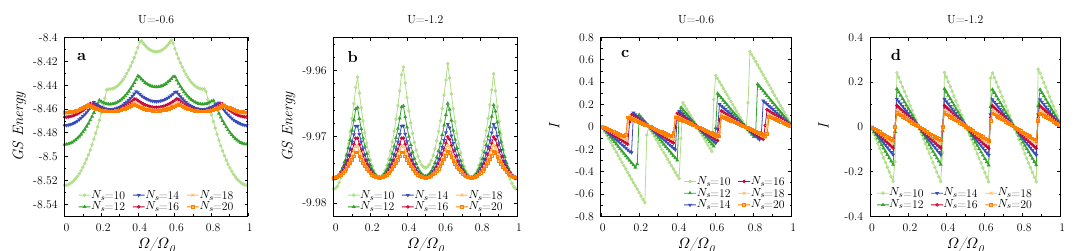
Figure 8: a , b ground state energy for different interaction as a function of the flux. ( Ω ) /∂ Ω , for different interaction as a function c , d current, calculated as I = − ∂ E GS of the